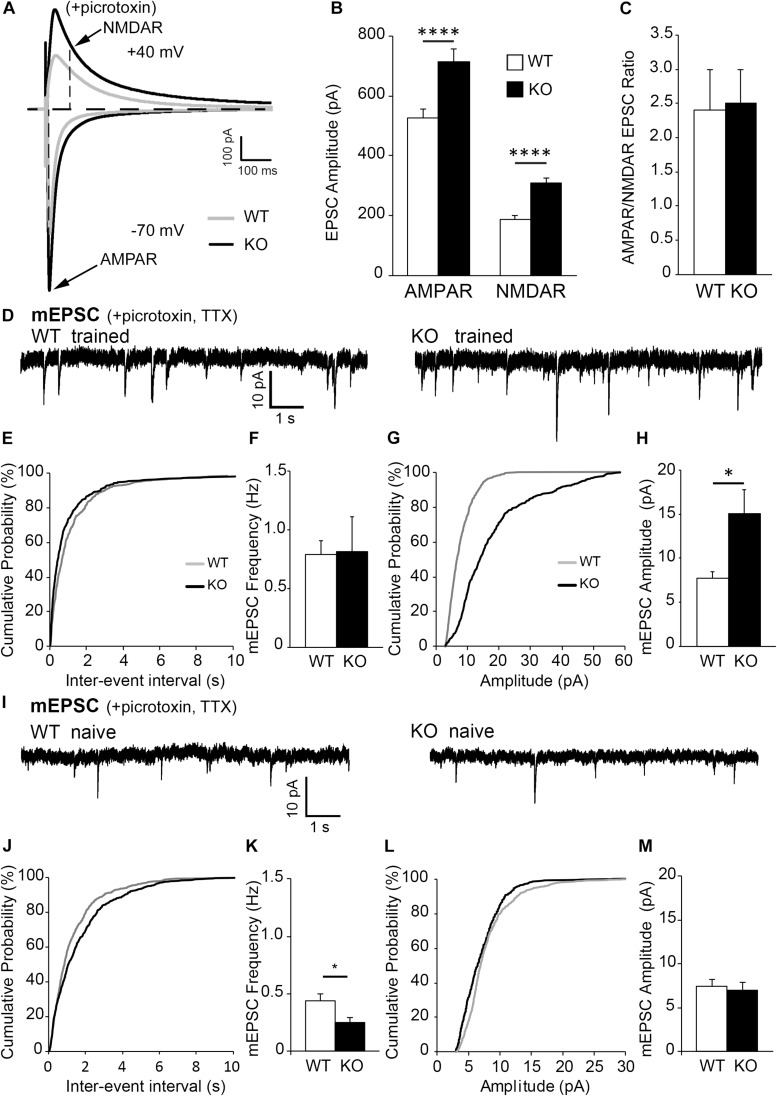
Excitatory post-synaptic responses are enhanced in CA1 hippocampal neurons from astrocytic ephrin-B1 KO mice compared to WT mice. (A) Representative traces of excitatory postsynaptic responses in CA1 hippocampal neurons in hippocampal slices from WT (gray) and KO (black) trained mice evoked by stimulating CA3 Schaffer collaterals in the presence of 50 μM picrotoxin, a GABAA receptor antagonist. Neurons were voltage-clamped at either –70 mV to measure AMPAR-mediated EPSCs or +40 mV to measure NMDAR-mediated EPSCs. (B,C) Graphs show average EPSC amplitude (B) and corresponding ratio of AMPAR- and NMDAR-mediated EPSCs (C) (n = 12–13 cells, six mice). Evoked AMPAR and NMDAR-mediated currents were significantly increased (AMPAR: t(398) = 3.568, ∗∗∗p = 0.0004; NMDAR: t(373) = 4.61, p < 0.0001, t-test, ****p < 0.0001); however, AMPAR/NMDAR EPSC ratio was unchanged (t(17) = 0.1495, p = 0.8829, t-test). (D) Sample recordings of mEPSCs from CA1 neurons in hippocampal slices from trained WT and KO mice; recorded in the presence of TTX and picrotoxin (n = 6 mice). (E) Cumulative probability curve of inter-event intervals between spikes in WT (gray) and KO (black). (F) Total average frequency of mEPSCs in WT and KO. (G) Cumulative probability curve of mEPSC amplitude in WT and KO. (H) Average amplitude of mEPSCs was significantly higher in KO compared to WT (t(12) = 2.927, ∗p = 0.0127, t-test). (I) Sample recordings of mEPSCs from CA1 neurons in hippocampal slices from naïve WT and KO mice; recorded in the presence of TTX and picrotoxin (n = 6 mice). (J) Cumulative probability curve of inter-event intervals between spikes in naïve WT (gray) and KO (black). (K) Total average frequency of mEPSCs in naïve WT and KO. Average frequency of mEPSCs was significantly lower in naïve KO than WT mice (t(10) = 2.561, ∗p = 0.0283). (L) Cumulative probability curve of mEPSC amplitude in naïve WT and KO. (M) Average amplitude of mEPSCs between naïve WT and KO. Error bars represent SEM; ∗p < 0.05, ****p < 0.0001.